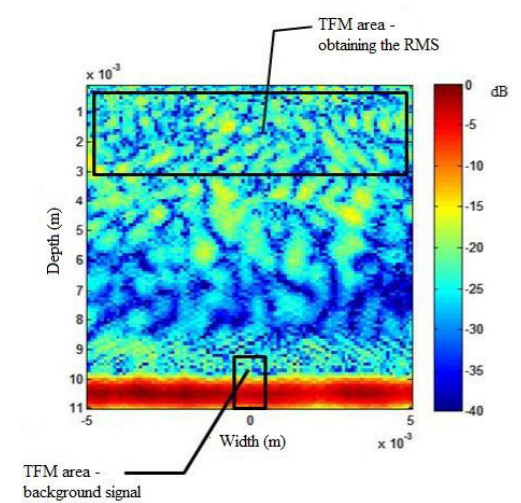
Figure 6. TFM image showing the main regions employed with the TFM